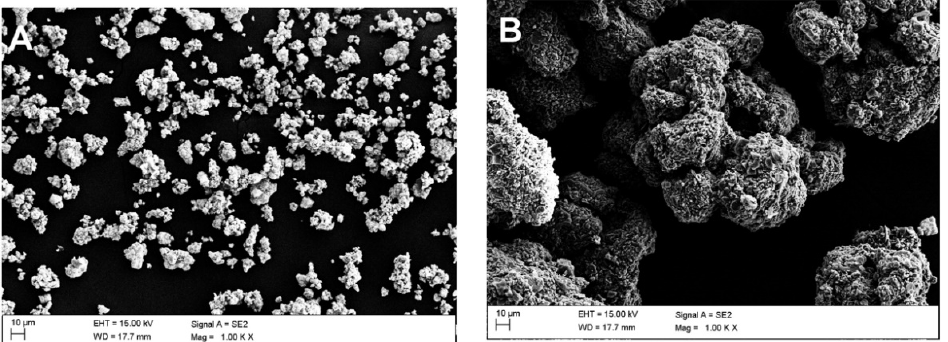
Figure 5. Morphology of the APTES-modified zirconia and alumina powders: ( A ) ZrO 2 _0 and ( B ) Al 2 O 3 _0.